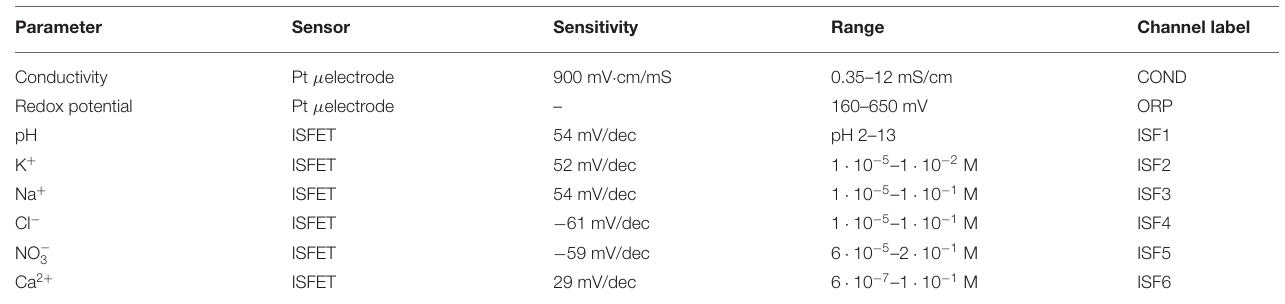
TABLE 1 | Technical specifications of the IMB-CNM’s electrochemical microsensors used in this work. Parameter Sensor Sensitivity Range Channel label